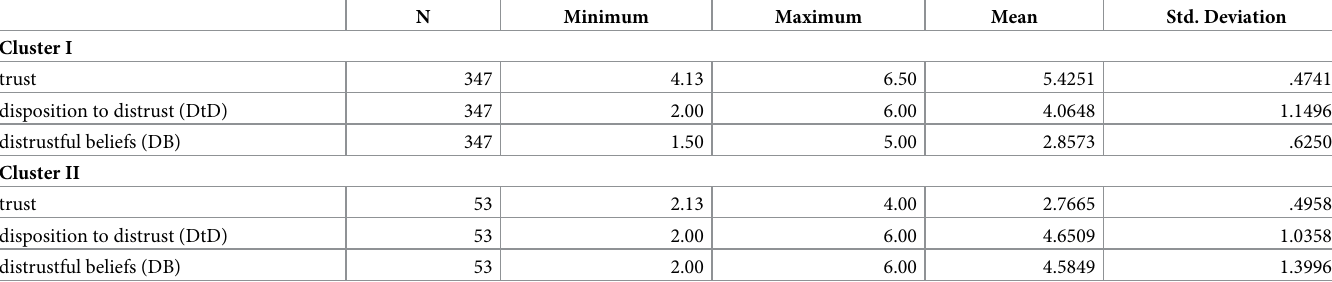
Table 16. Descriptive statistics for both clusters in the frame of the relationship between trust and distrust